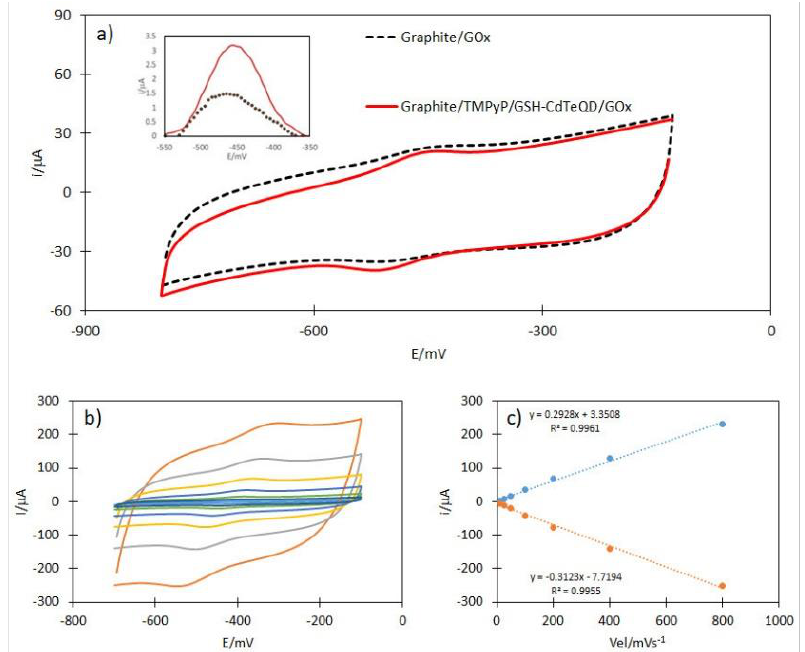
Figure 7. ( a ) Voltammograms of graphite electrodes modified with GOx (black dashed line) and with TMPyP/GSH-CdTeQD/GOx (red line). Peaks obtained after subtracting the baseline are shown in the insert. ( b ) CVs of TMPyP/GSH-CdTeQD/GOx modified electrodes at different scanning rates. ( c ) Linear correlation between the current increases and the scan rate.